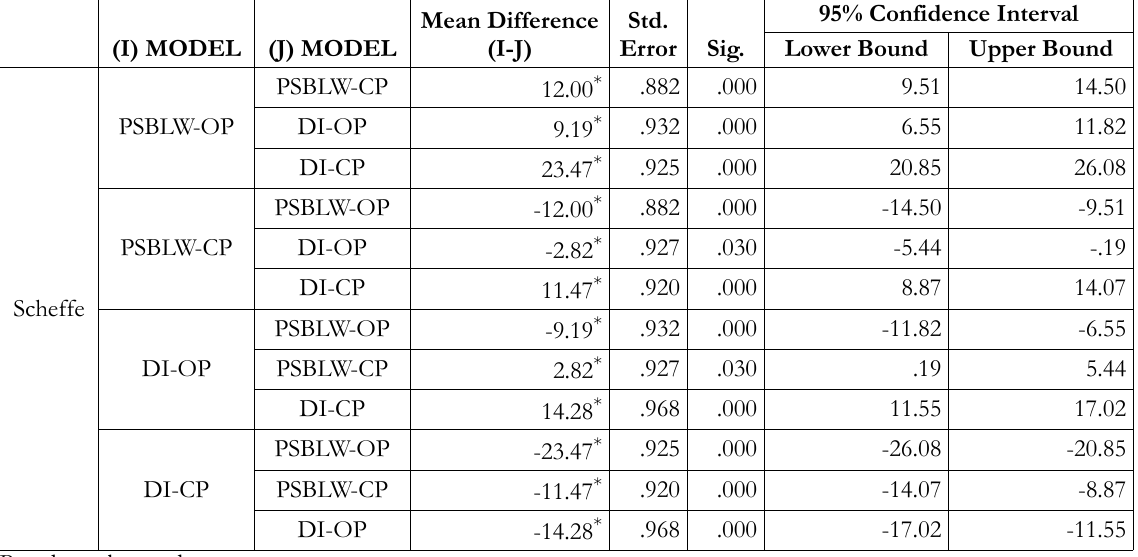
Table 5. Multiple Comparisons Mean (Dependent Variable: